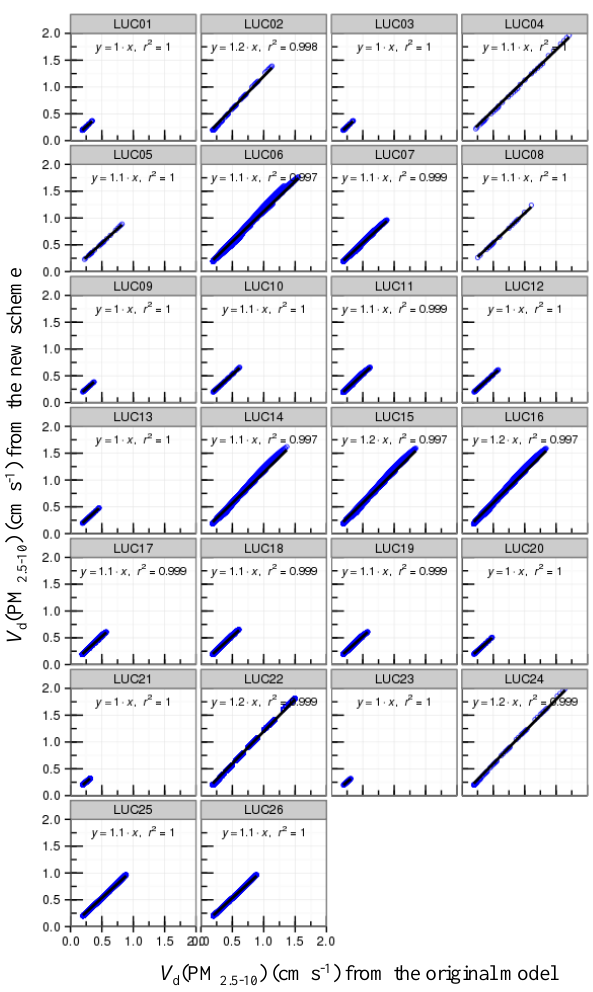
Fig. 5. Same as in Fig. 2 except for V d (PM 2 . 5 − 10 )